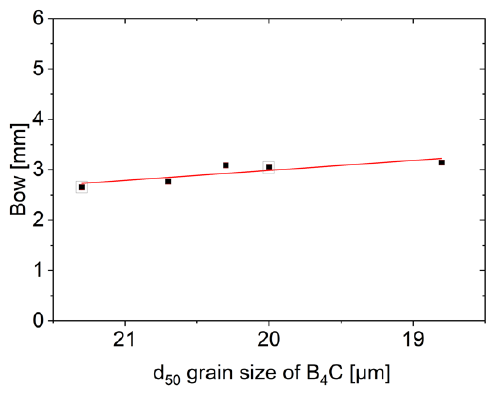
Figure 13. E ff ect of abrasive particle wear on the size of the bow ( y = − 0.2 ( ± 0.1 ) x + 7 ( ± 1.5 ) ; Figure 13. Effect of abrasive particle wear on the size of the bow ( 𝑦 (cid:3404) (cid:3398)0.2 (cid:4666)(cid:3399)0.1(cid:4667) 𝑥 (cid:3397) 7 (cid:4666)(cid:3399)1.5(cid:4667) ; COD Figure 13. Effect of abrasive particle wear on the size of the bow ( 𝑦 (cid:3404) (cid:3398)0.2 (cid:4666)(cid:3399)0.1(cid:4667) 𝑥 (cid:3397) 7 (cid:4666)(cid:3399)1.5(cid:4667) ; COD COD (r 2 ): 0.72). The d 50 grain sizes of the grey marked data points are not measured (r 2 ): 0.72). The d 50 grain sizes of the grey marked data points are not measured experimentally. (r 2 ): 0.72). The d 50 grain sizes of the grey marked data points are not measured experimentally.